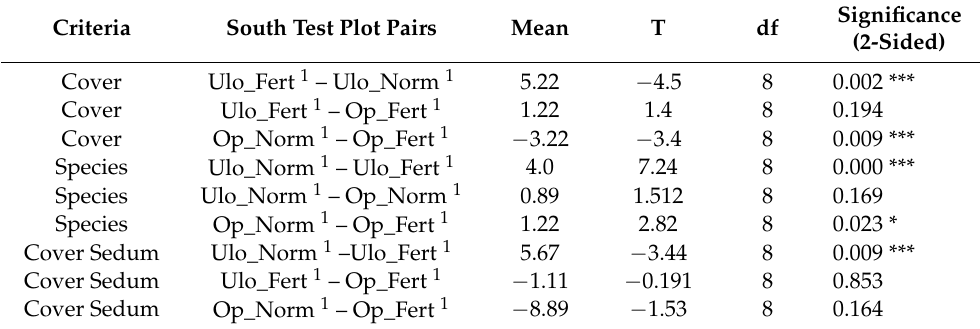
Table 17. Greening with turf mats, n=9 years, from 2011 to 2020 (df 8), coverage and number of species for the test plots with fertilizer (Fert.) and without (Norm.) of the southern position. Pairwise t -test and the level of significance. As explanation e.g. in line 1; also the south plots has a profit in cover value by the fertilizer, in this case on the 2‰-level. On the other hand, the fertilizer reduces the number of species. The Sedum cover is not significant influenced by the fertilizer. Criteria South Test Plot